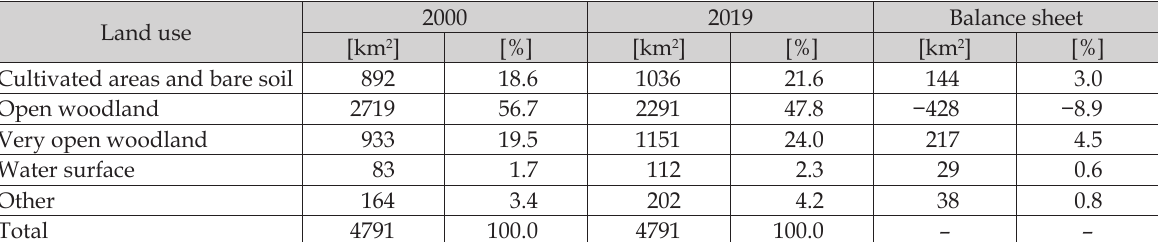
Table 6. Area land use in 2000 and 2019.